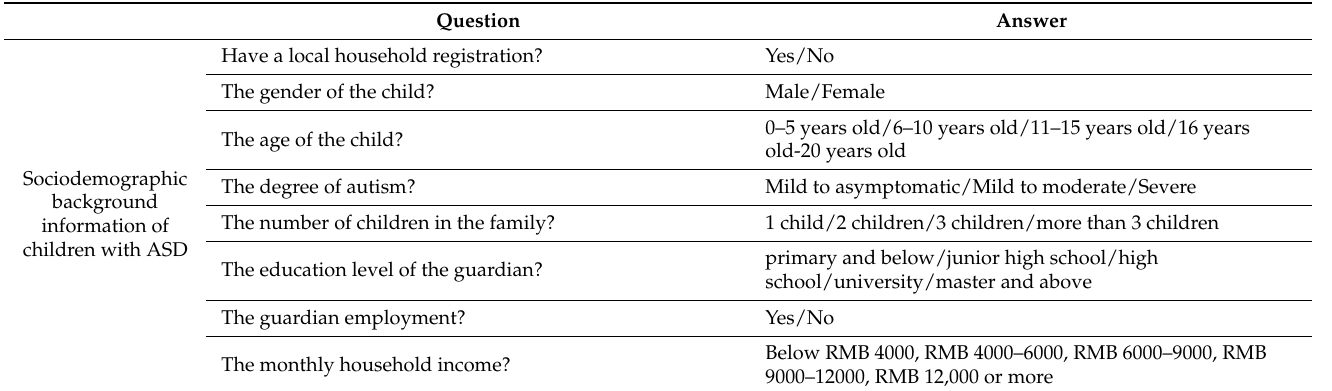
Table 4. Anonymous Questionnaire